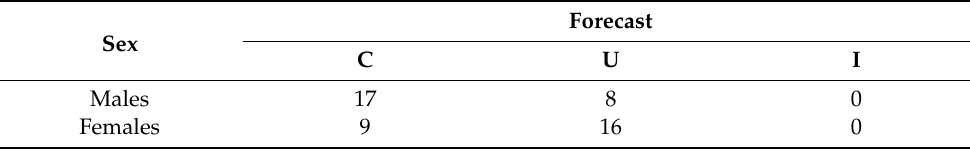
Table 3. The frequency distribution of the forecasts of the expected end of the spurt periods using regression model (1) for the 50 subjects belongs to the Michigan Growth